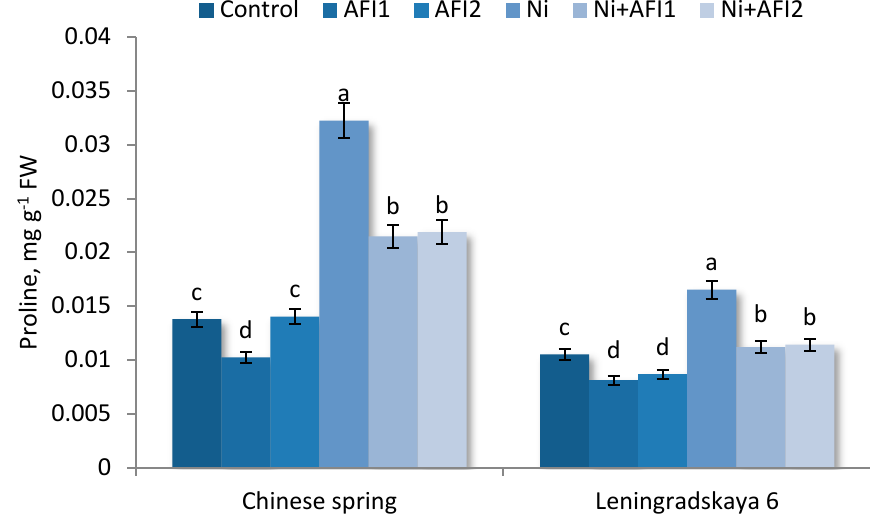
Figure 6. Proline content in wheat shoots of Ch. spring S and Leningrad.6 T under Ni exposure and after bacterial inoculation. Different letters indicate a significant difference between the means at the probability level of p < 0.05, as determined by Duncan’s multiple range